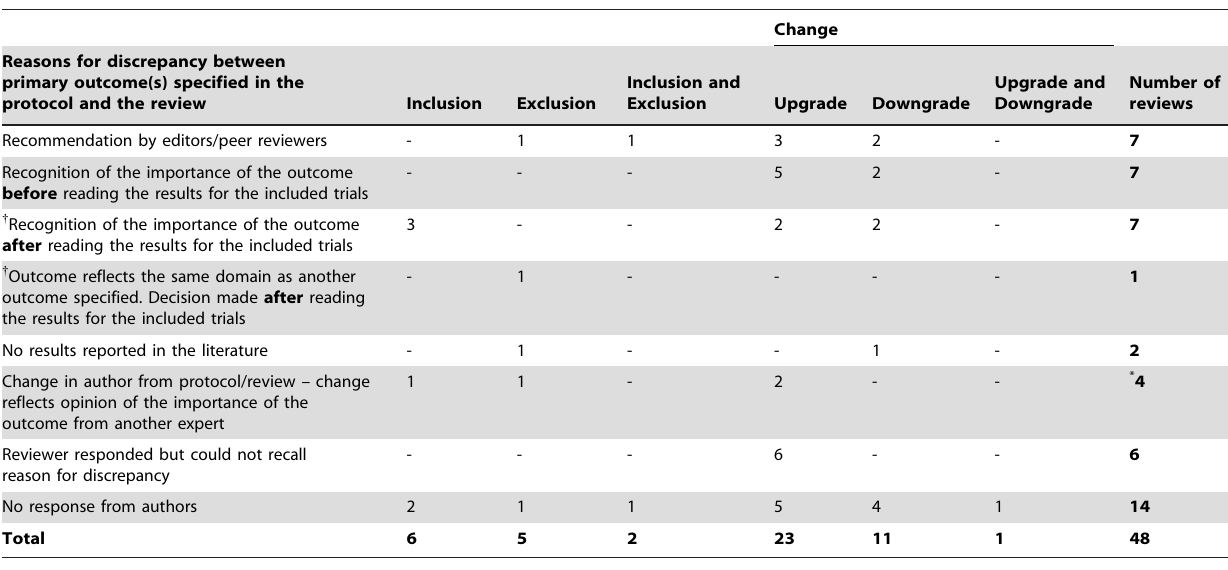
Table 1. Reasons for discrepancies in primary outcome measures.